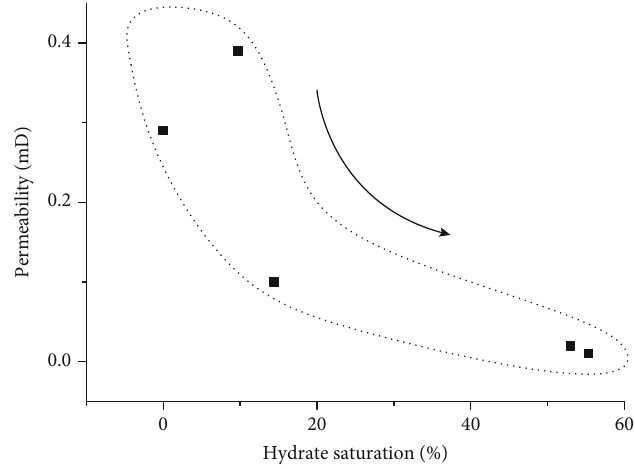
Figure 6: Relation between the permeability and hydrate saturation.